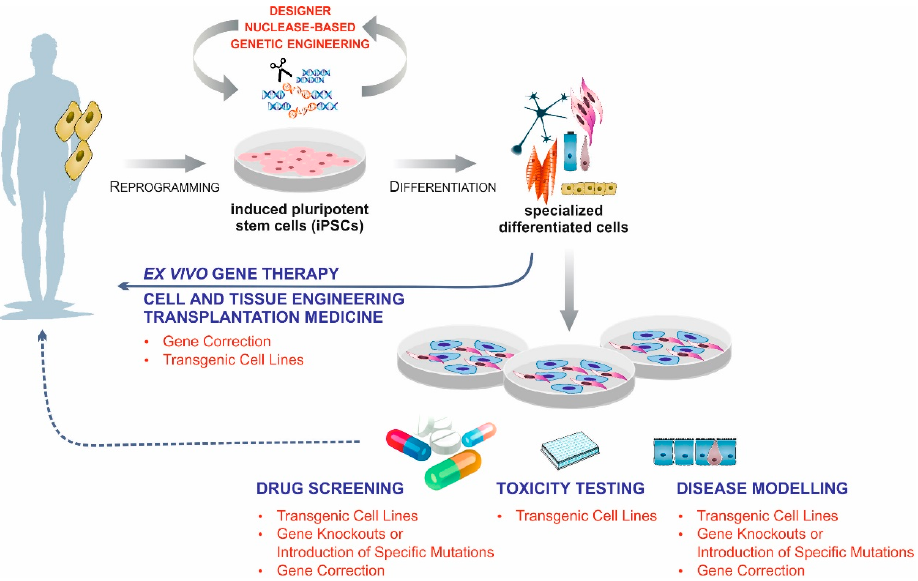
Figure 1. The ability to genetically modify induced pluripotent stem cells (iPSCs) is indispensable